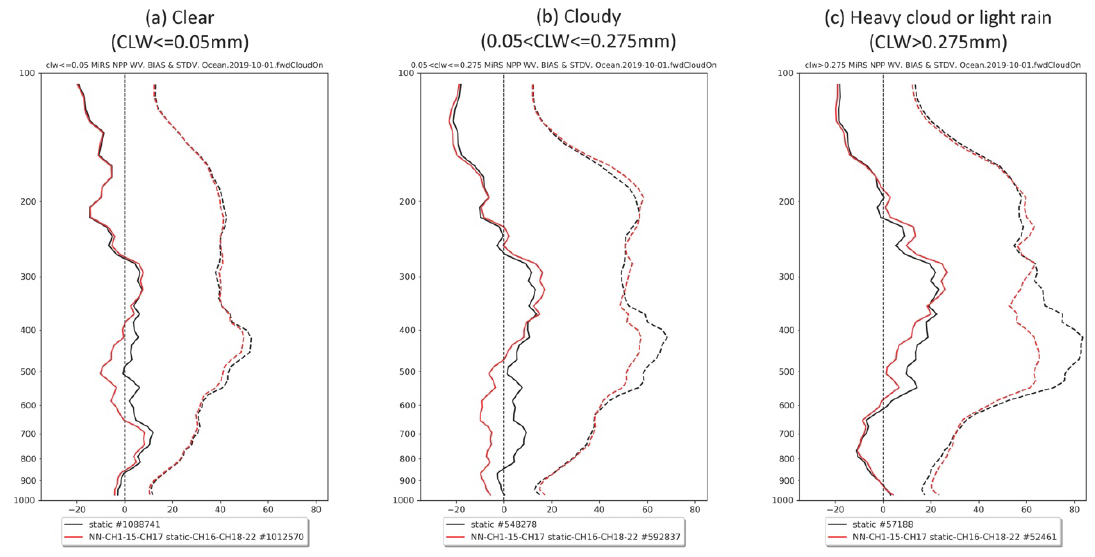
Figure 6. Similar to Figure 5 but for water vapor profiles. Bias and standard deviation are the percentage mixing ratio with respect to the mean ECMWF analysis at each layer.